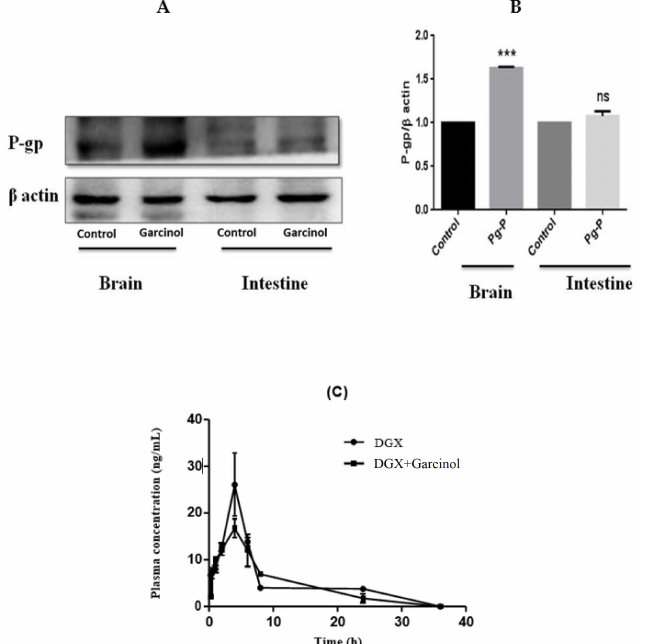
Figure 3. The effect of garcinol on the P-gp expression in brain and intestinal tissues ( A ) and graph showing the difference between control and garcinol treated groups (*** p < 0.05) ( B ) and plasma concentration vs. time graph showing the effect of garcinol on the P-gp function in SD rats ( C